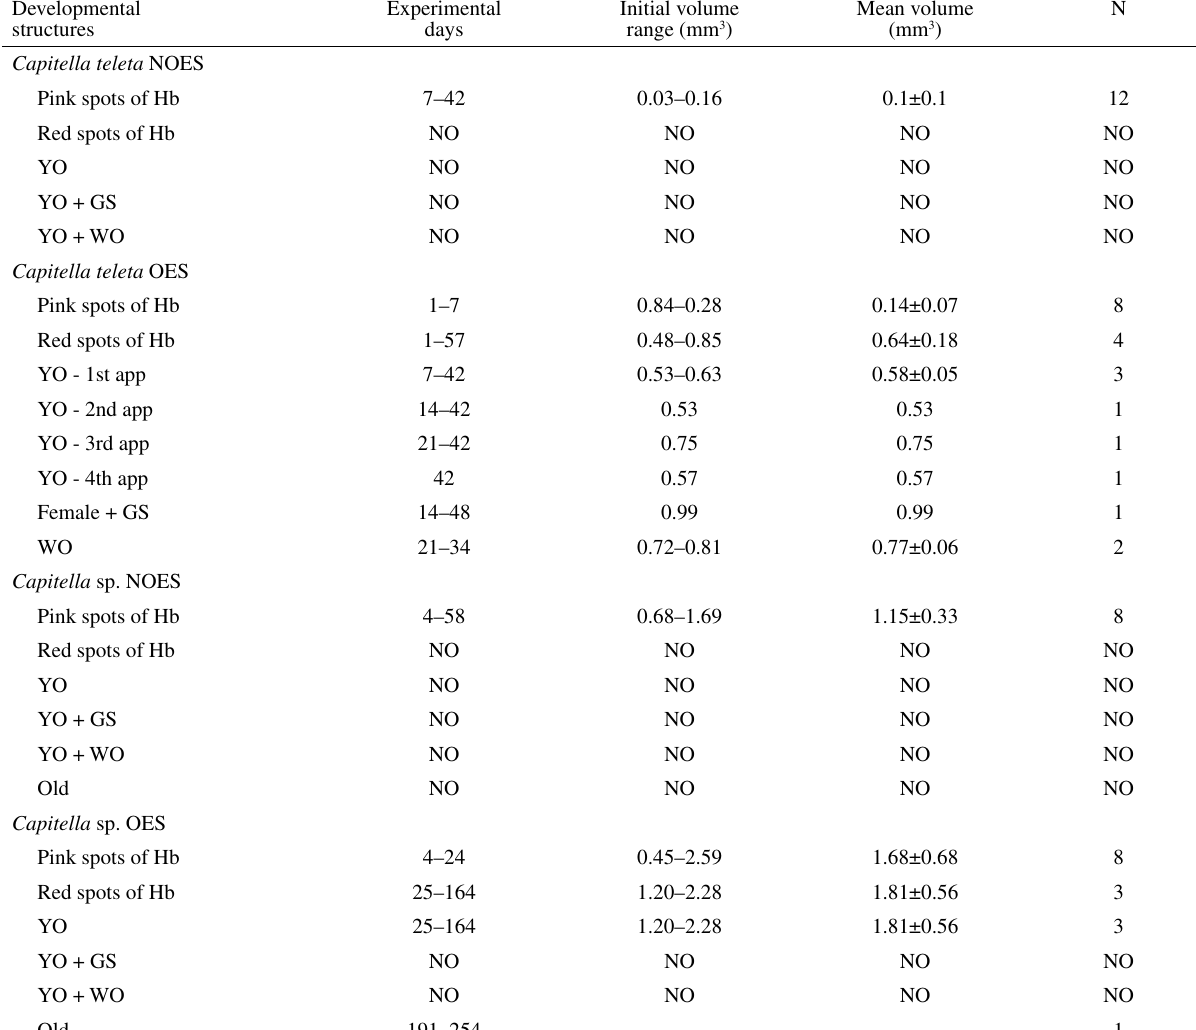
Table 3. – Development of reproductive structures in juveniles and their initial and average (± standard deviation) body volumes. NO, not observed; Hb, haemoglobin, YO, yellow ovaries; WO, white ovaries; GS, genital spines; 1st app to 4th app, appearance of yellow ovaries. Developmental